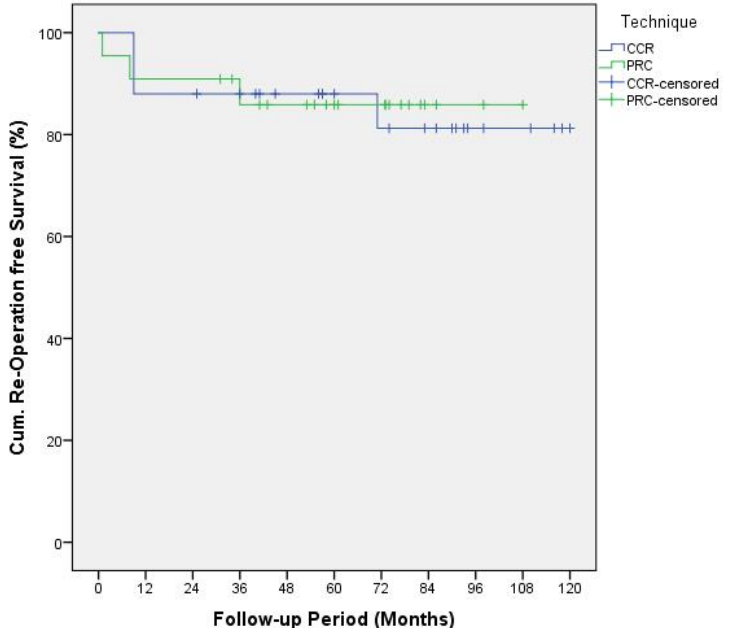
Figure 3. Kaplan–Meier Plot displaying cumulative re-operation-free survival functions.